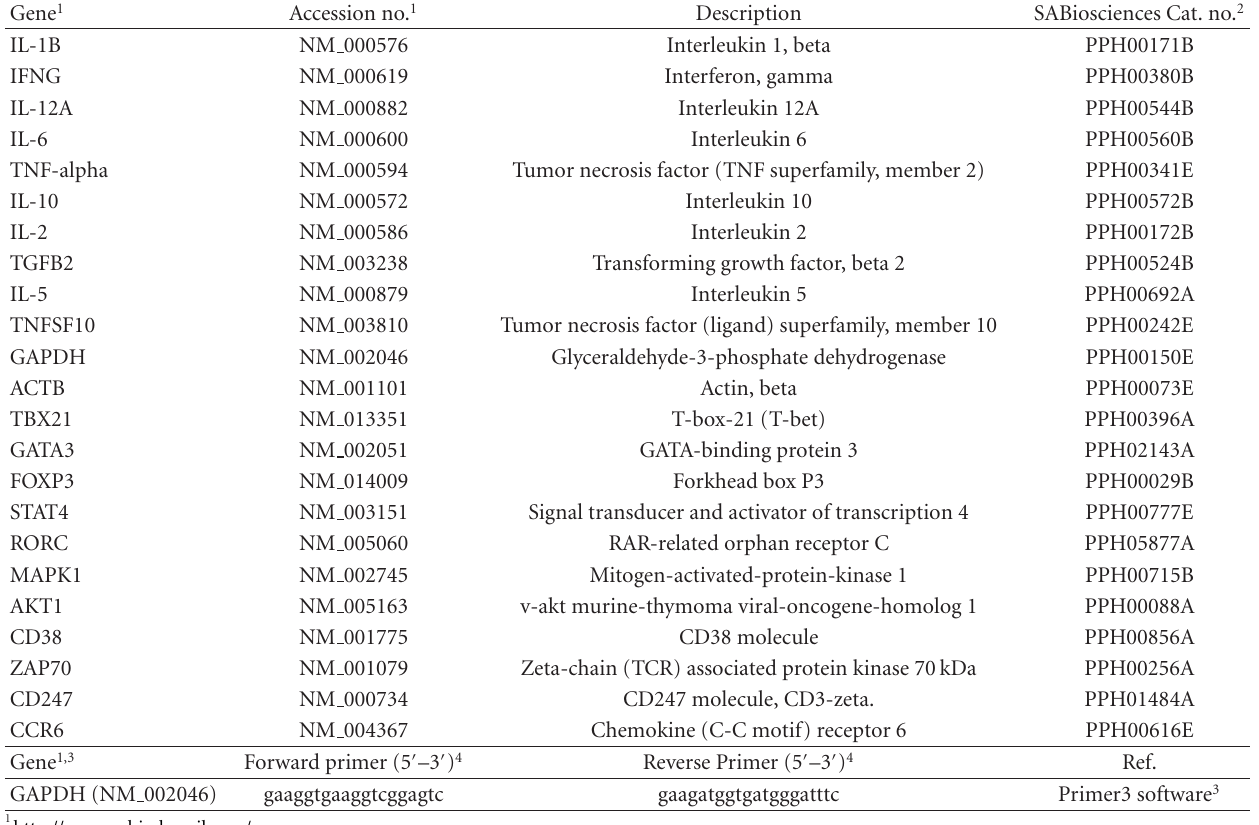
Table 2: Primers for quantitative